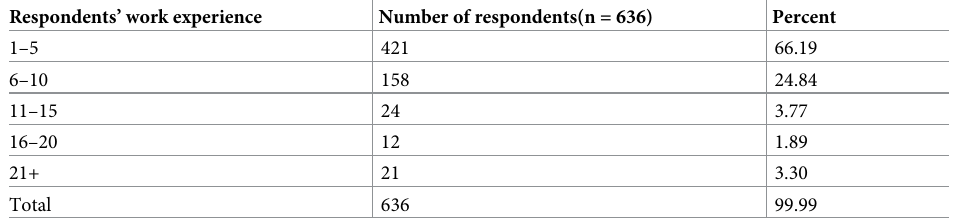
Table 3. Study respondents’ work experience at the study health facilities, Addis Ababa City Administration, Feb- ruary